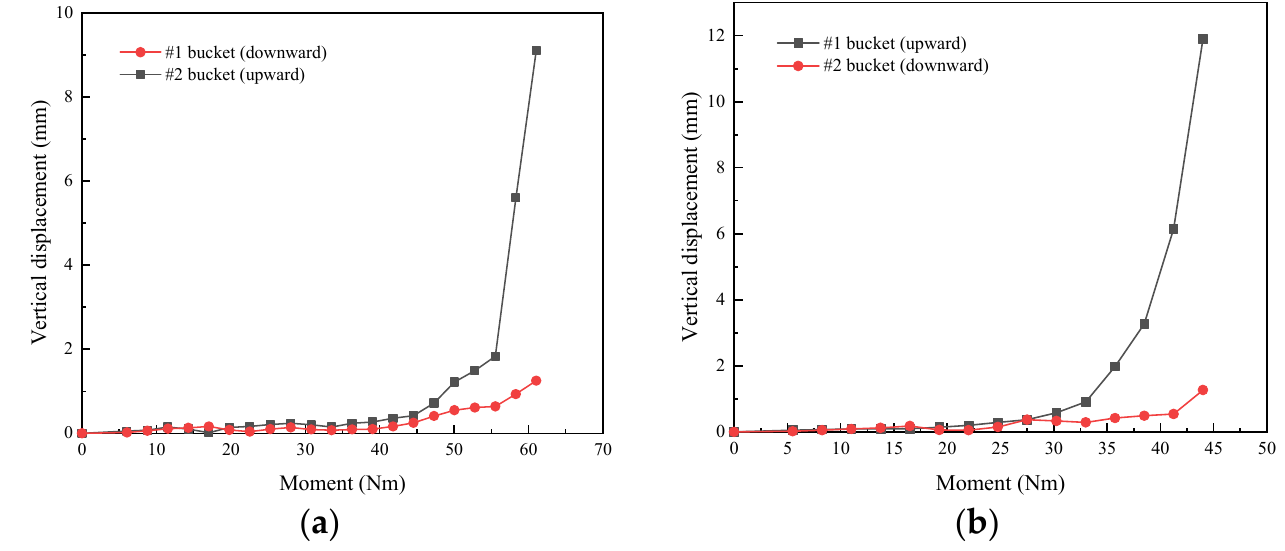
Figure 6. Vertical displacement of bucket: ( a ) two buckets in tension, ( b ) one bucket in tension. As shown in Figure 7, the position of the instantaneous rotation center for the tested model can be estimated from two vertical displacement measurements at the top lid